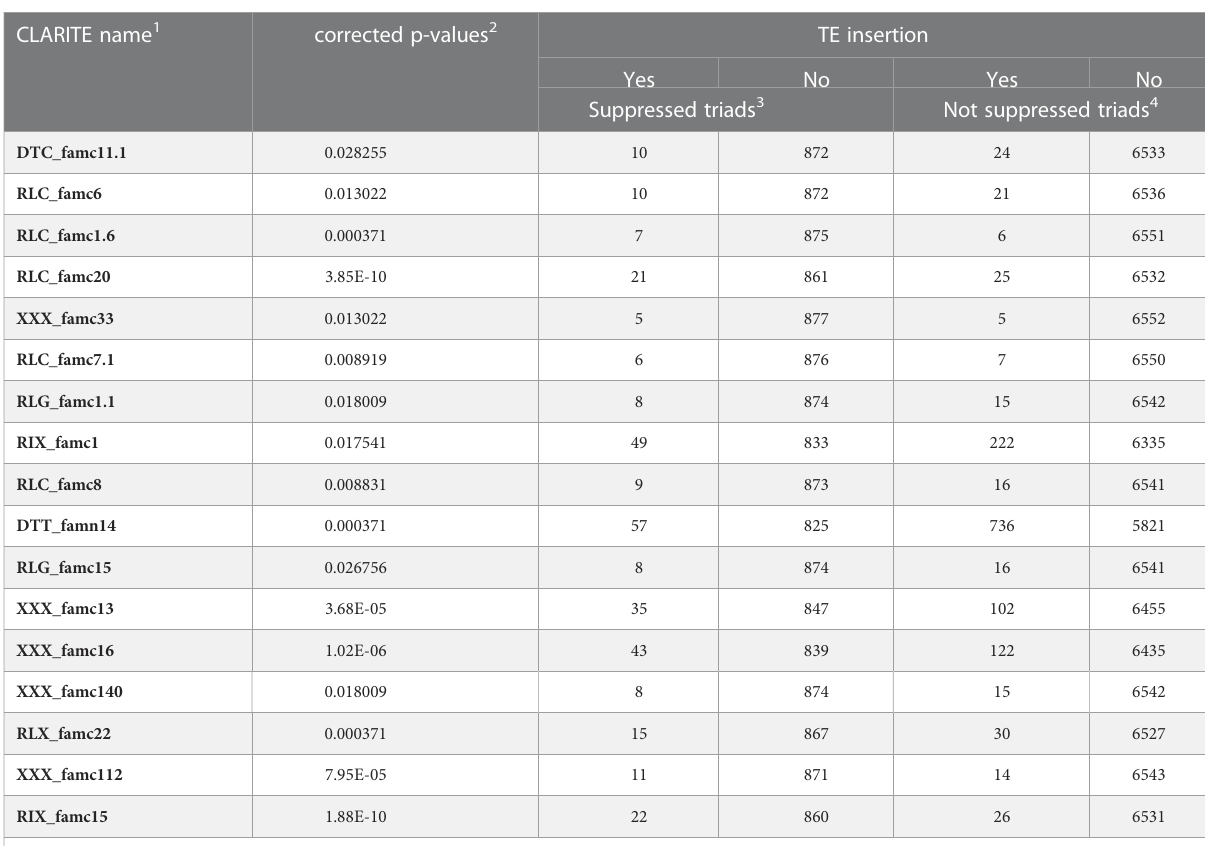
TABLE 4 TE subfamilies for which the presence/absence of TE insertion in at least one of the triad genes correlated with the suppression of a single homoeolog